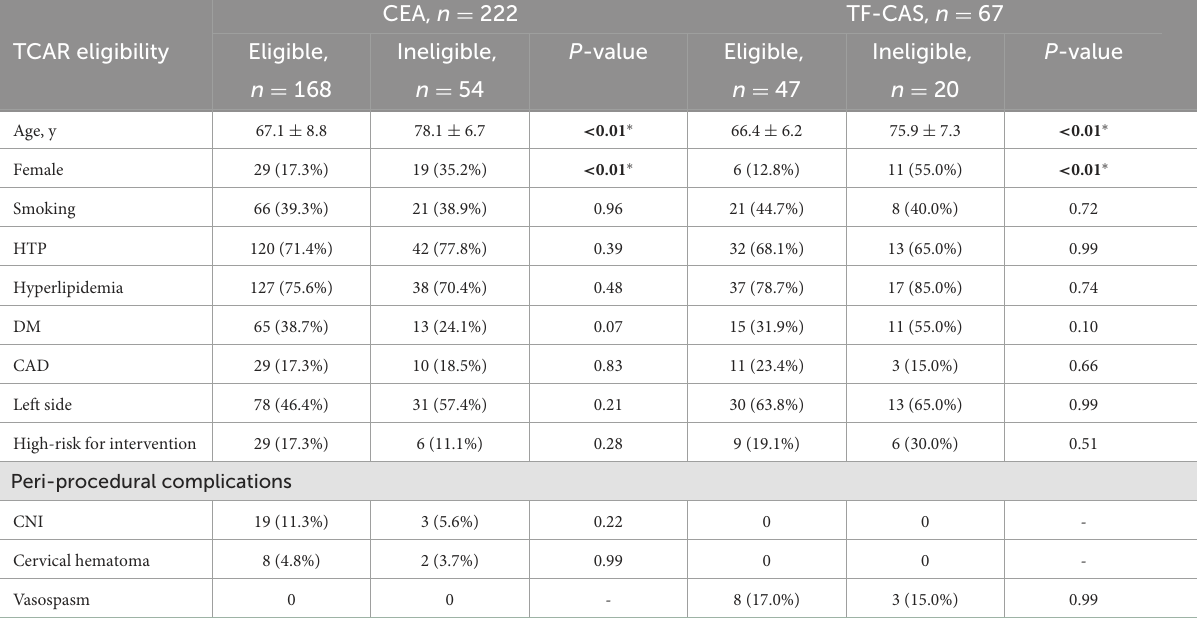
TABLE 4 Patient characteristics of CEA and TF-CAS, eligible vs. ineligible for